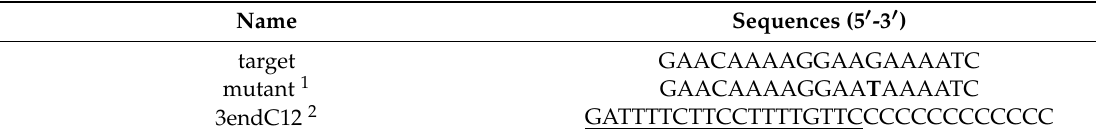
(Table 1, mutant) is linked to familial breast and ovarian cancers [46,47]. 3endC12 (Table 1) was the designed template for Ag NC synthesis, and contains a complementary part of the target sequence for recognition as well as a C12 template at the 3 (cid:48) end for the encapsulation of Ag NCs (Figure 6a). Table 1. Sequences used for DNA detection in this work. Table 1. Sequences used for DNA detection in this work.